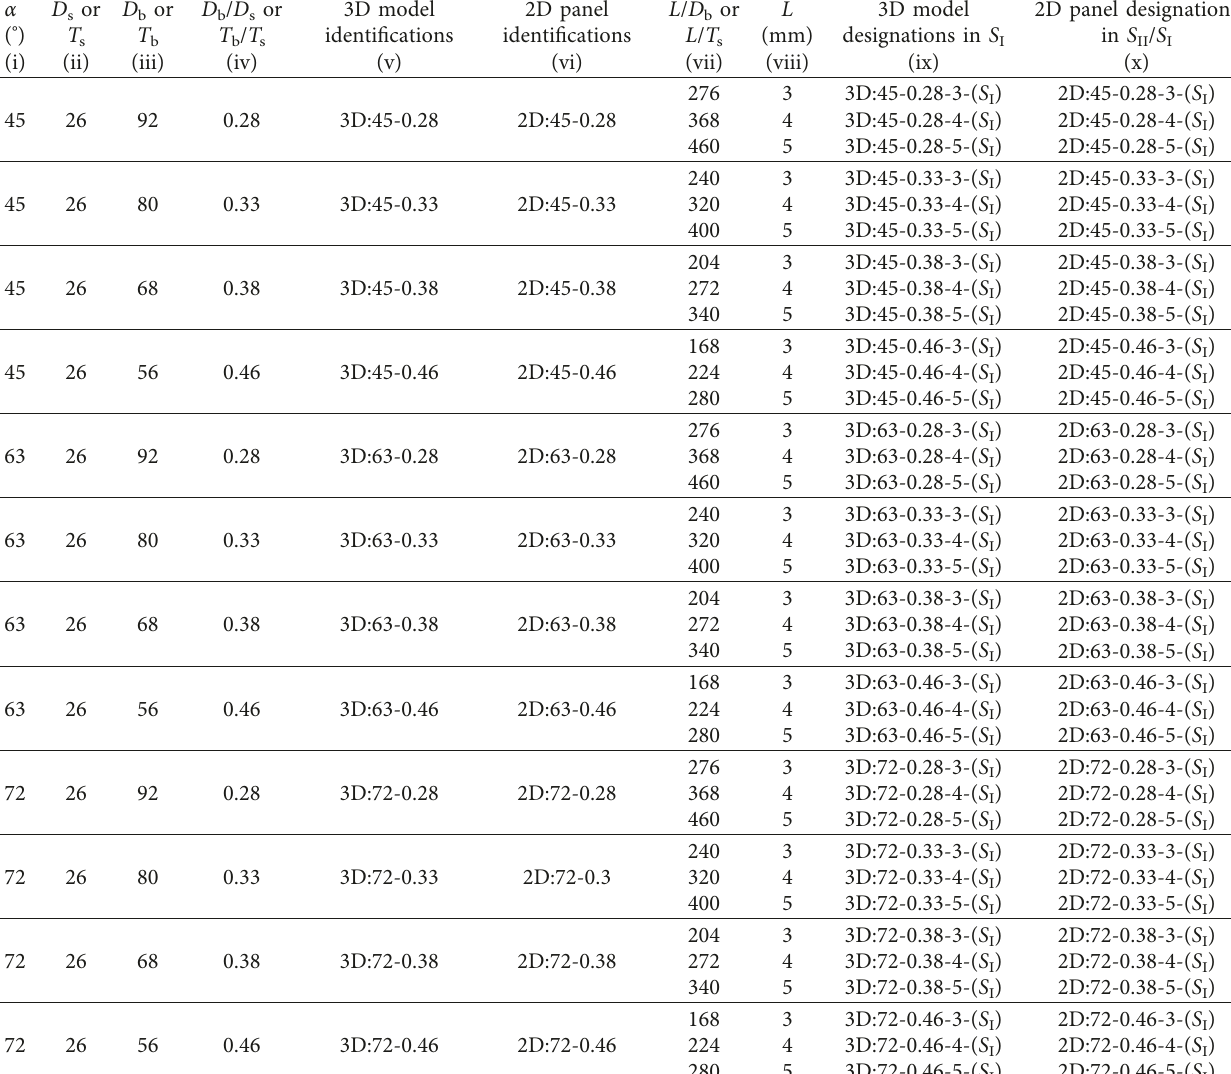
Table 2: Detail geometry of the 3D model and 2D panel and their designations in homogeneous sand deposit ( S